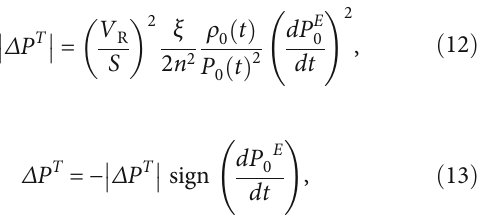
, and volume of the air vh